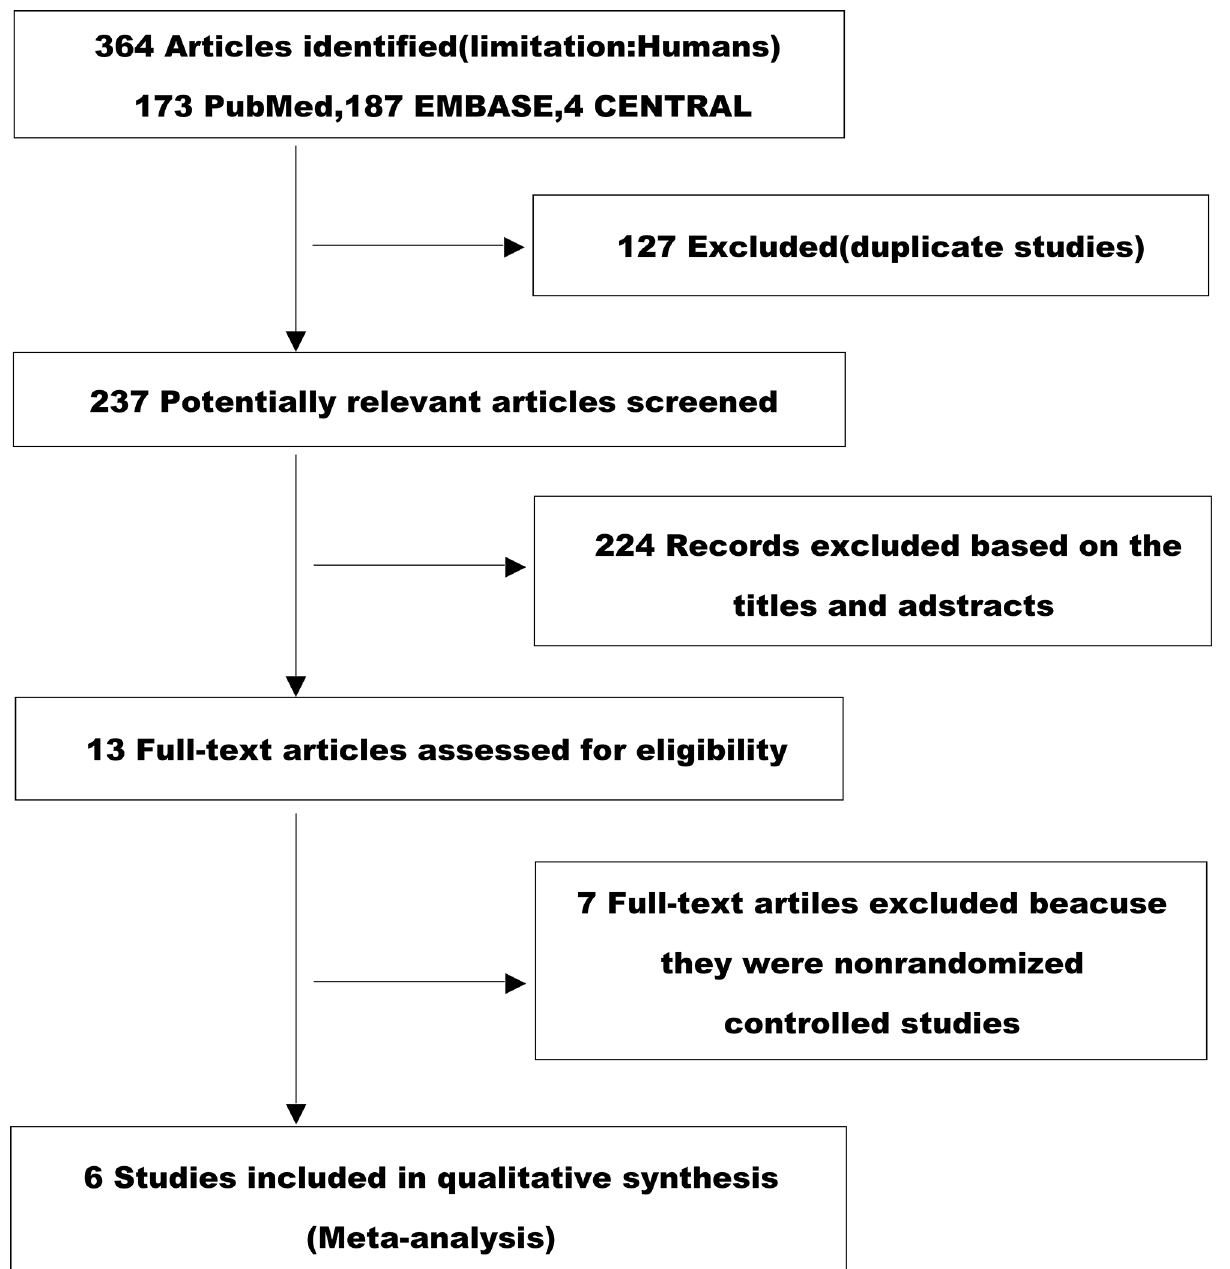
Fig 1. Study Flow Chart. A flow chart showing the process by which studies were selected for inclusion in this systematic